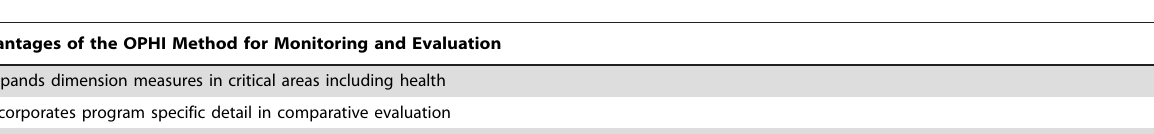
Table 2. Use of the Oxford Poverty and Human Development Initiative (OPHI) Method for Monitoring and